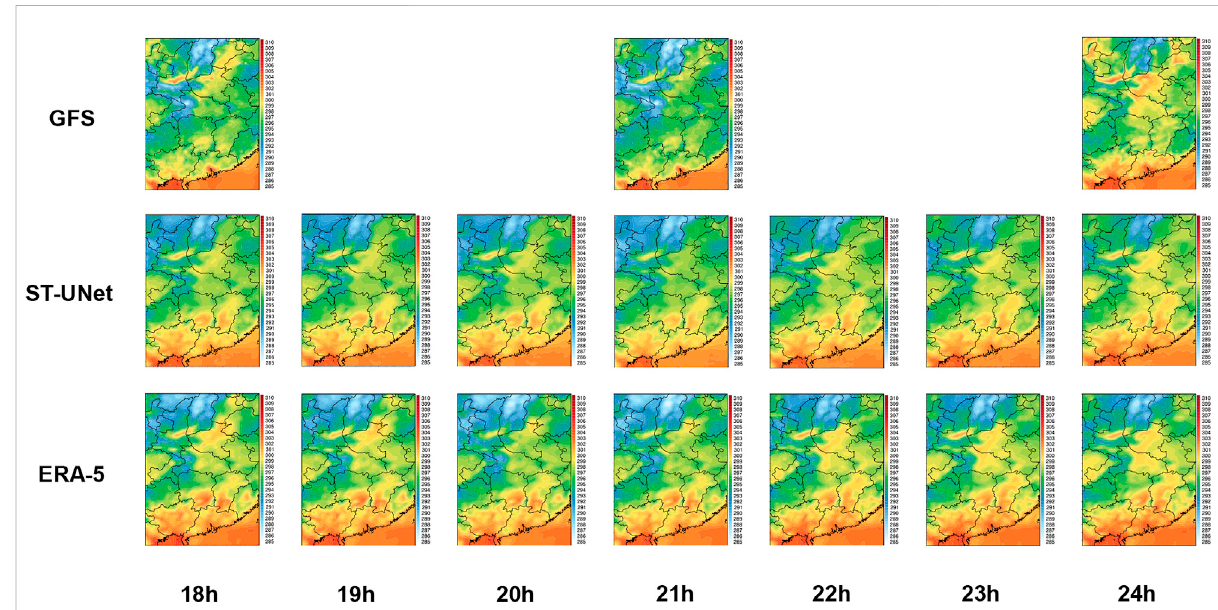
FIGURE 11 The distributions of 2-m temperature on the forecast time of 15 – 24 h, including GFS, ERA-5, and downscaling results obtained by